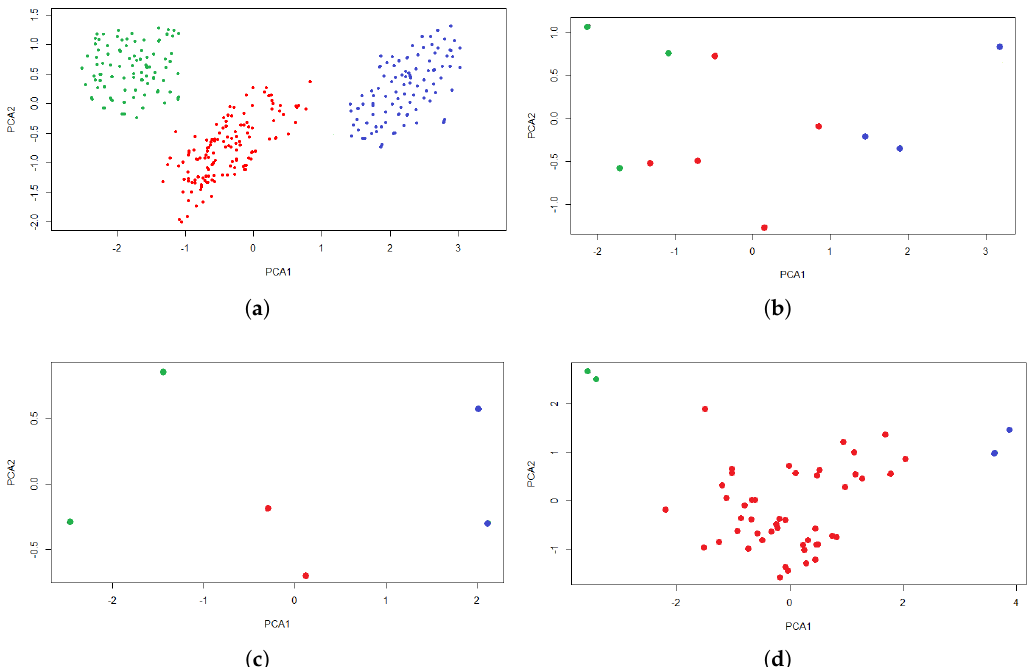
Figure 5. 2D scatter plots of resulting data matrices Z of the chosen prototype selection